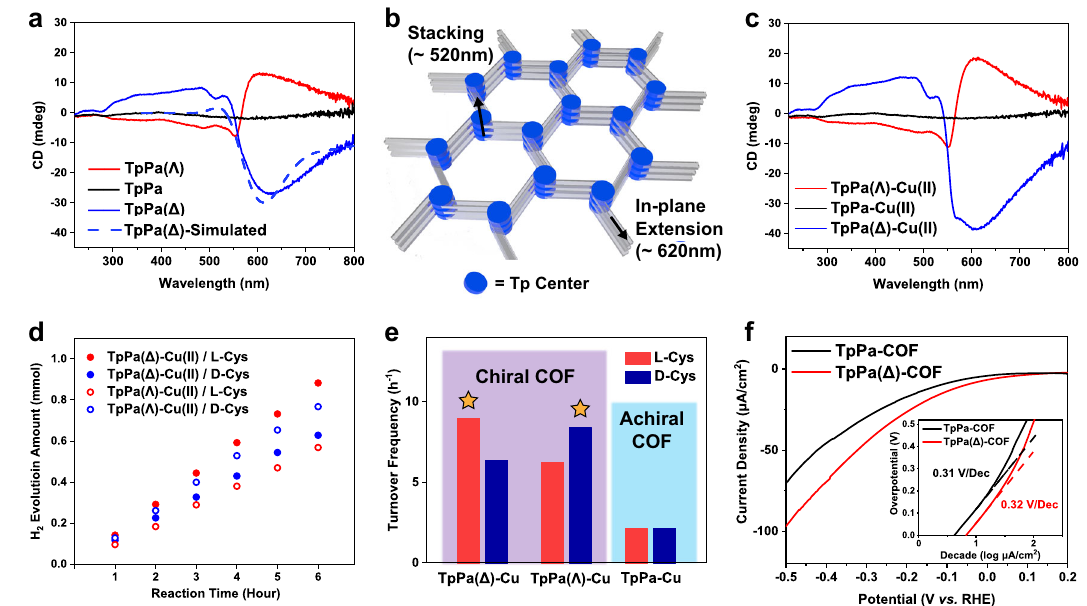
Fig. 3 | Chiraldichroism spectra,photocatalytic H2evolution and polarization curves. a Circular dichroism spectra of the achiral TpPa-COF, TpPa( Δ )-COF, TpPa( Λ )-COF, and double-layered TpPa( Δ ) model. b Proposed structural response to the circular dichroism signals in the chiral COF. c Circular dichroism spectra of the achiral TpPa-Cu(II)-COF, TpPa( Δ )-Cu(II)-COF and TpPa( Λ )-Cu(II)-COF. d Time- dependent photocatalytic H 2 evolution and e Sacri fi cial oxidation turnover